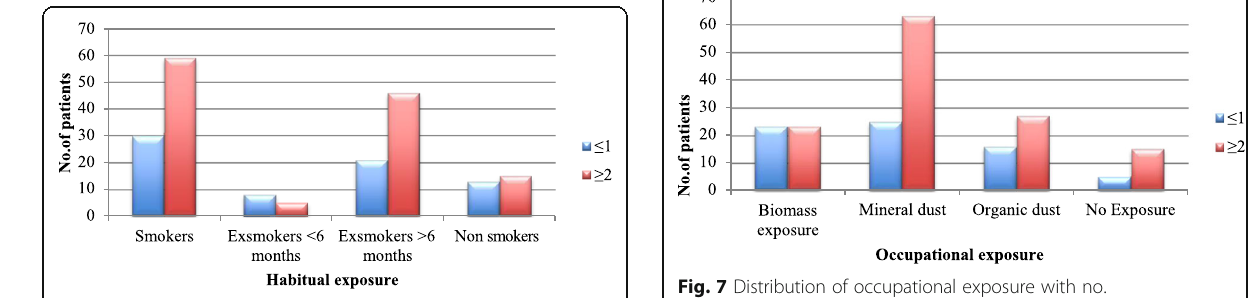
Fig. 6 Distribution of habitual exposure with no. of exacerbations